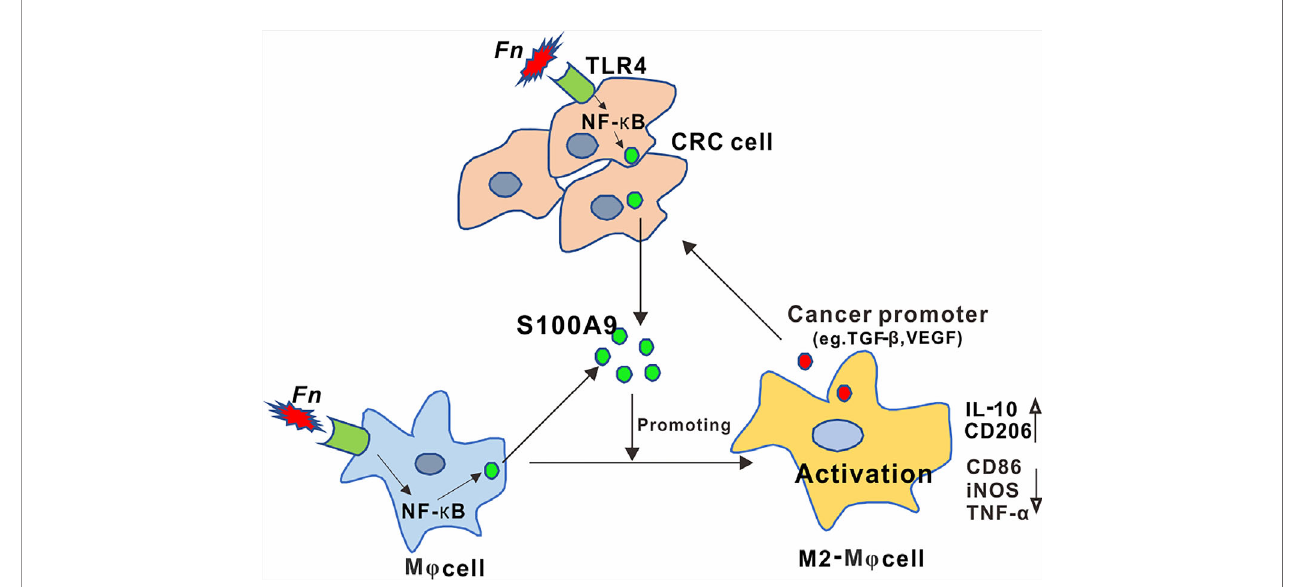
FIGURE 7 | Schematic diagram of the relationship among Fn , M2 polarization, and CRC progression. Activation of the TLR4/NF- k B cascade in M j and CRC cells by Fusobacterium nucleatum infection mediated high levels of S100A9 in CRC microenvironment, which led to M2-like M j phenotype showing increased IL-10 and CD206 levels, contributing to CRC